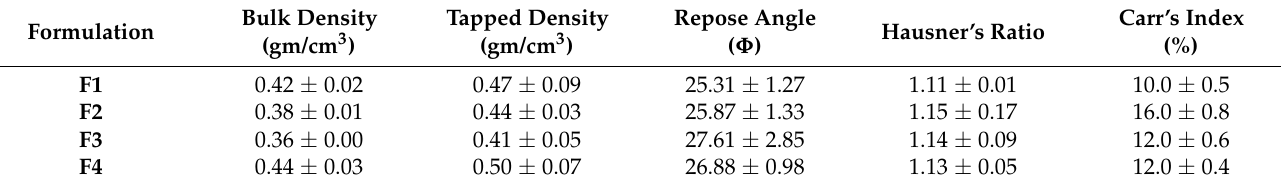
Table 2. Flow properties of powder blends.